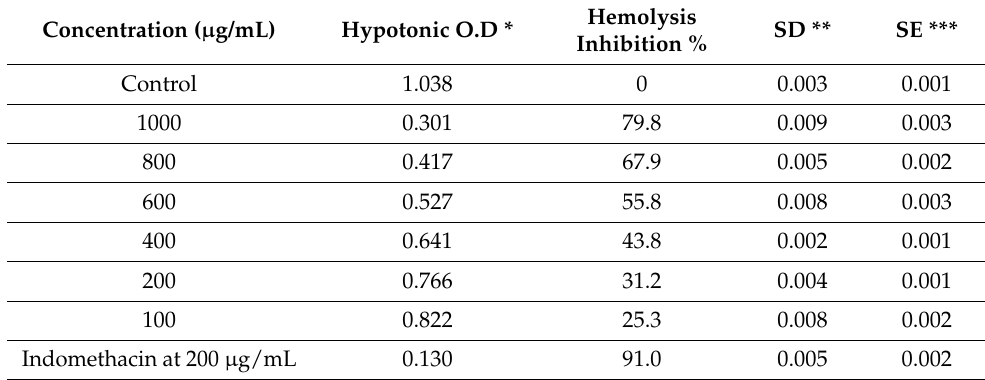
Table 5. Effect of M. pulegium extract on hemolysis inhibition.